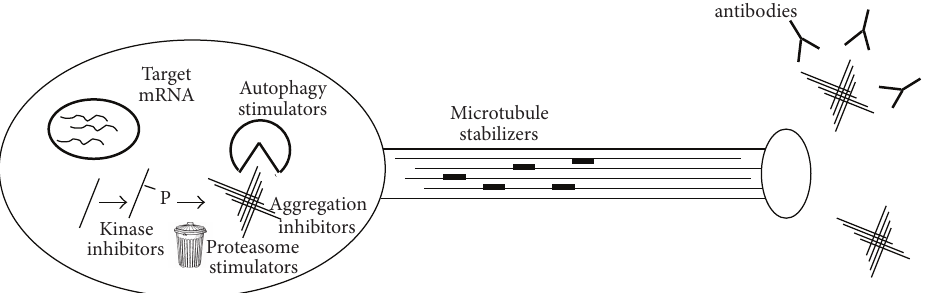
F 5: Targets for pharmacological modulation of tau and tau function. See text for